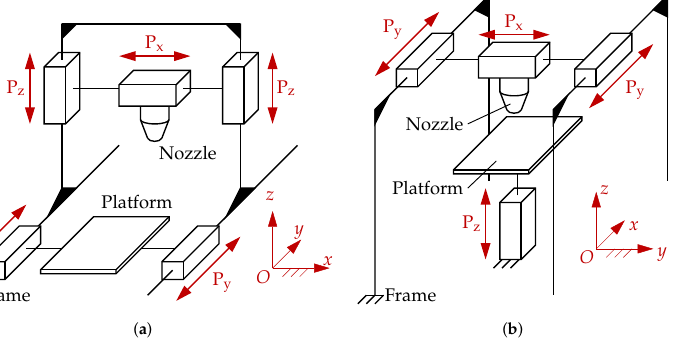
Figure 2. (a) : schematic of a printer with Cartesian XZ head architecture. (b) : same, for XY head. The rectangular cuboids are prismatic (P) joints, where the subscript ( x , y , or z ) denotes the motion axis.